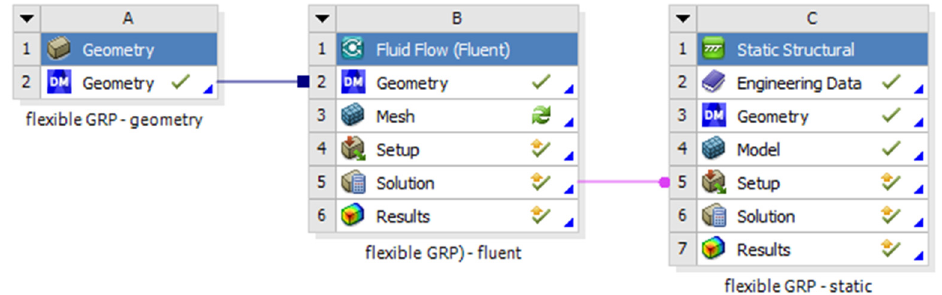
Figure 8. The coupling system.